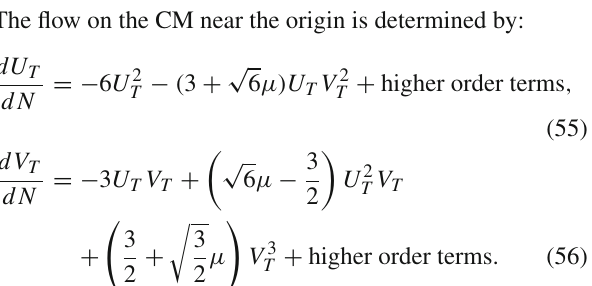
Fig. 5 Projection of the vector field on ( U T W T )-plane near the origin for the critical point P 4 ( α =